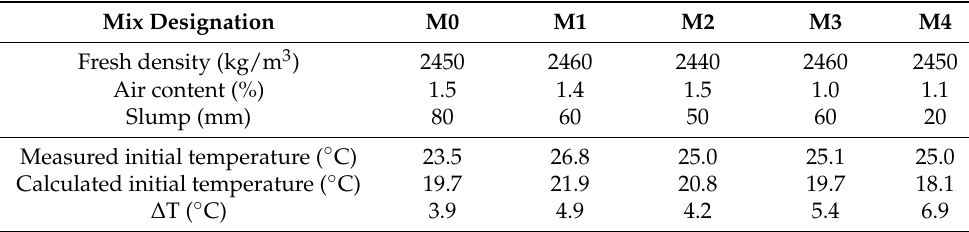
(Table 3). The air content was low in all mixtures, indicating dense packing of the con- crete constituents. Table 3. Properties of the fresh and hardened